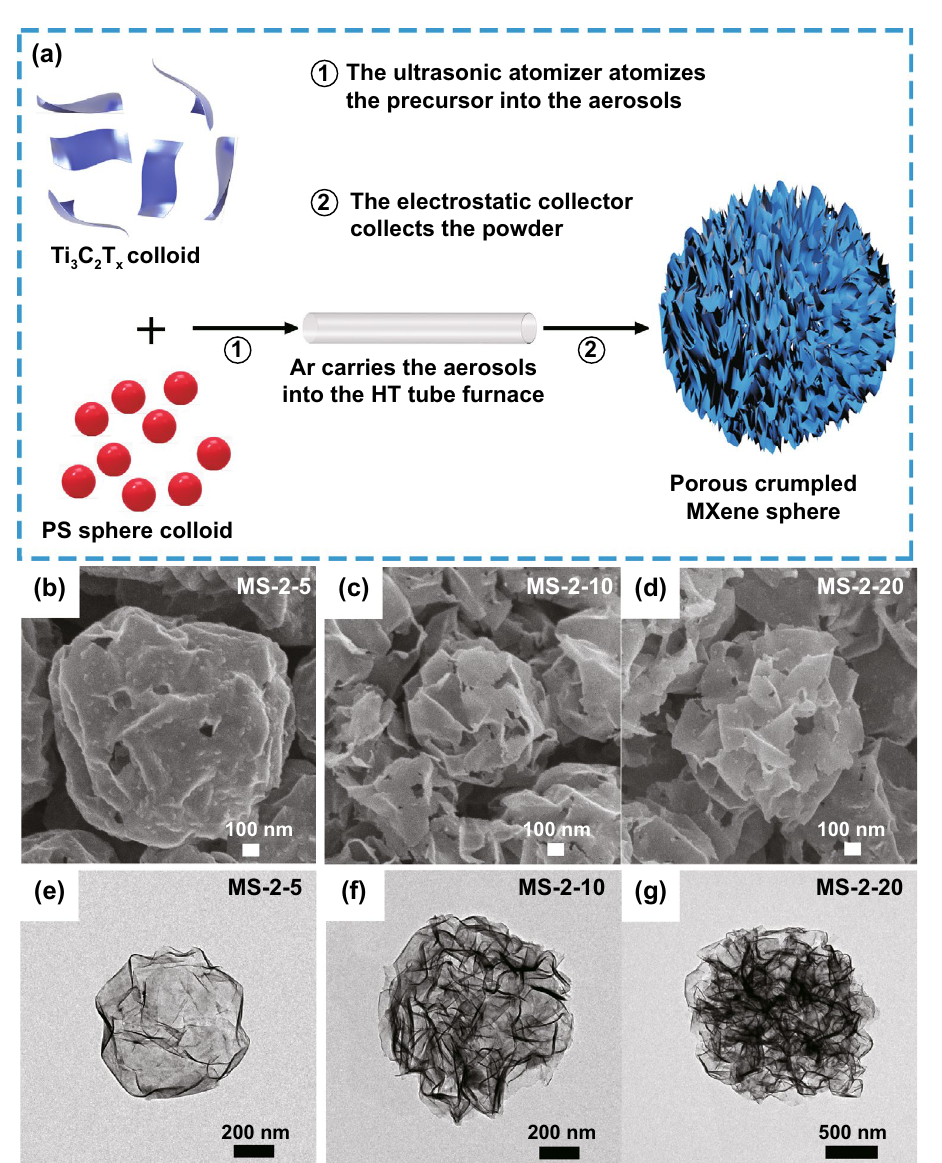
Fig. 1 a The synthesis scheme of porous crumpled MXene spheres. SEM images of b MS-2-5, c MS-2-10, and d MS-2-20. TEM images of e MS-2-5, f MS-2-10, and g